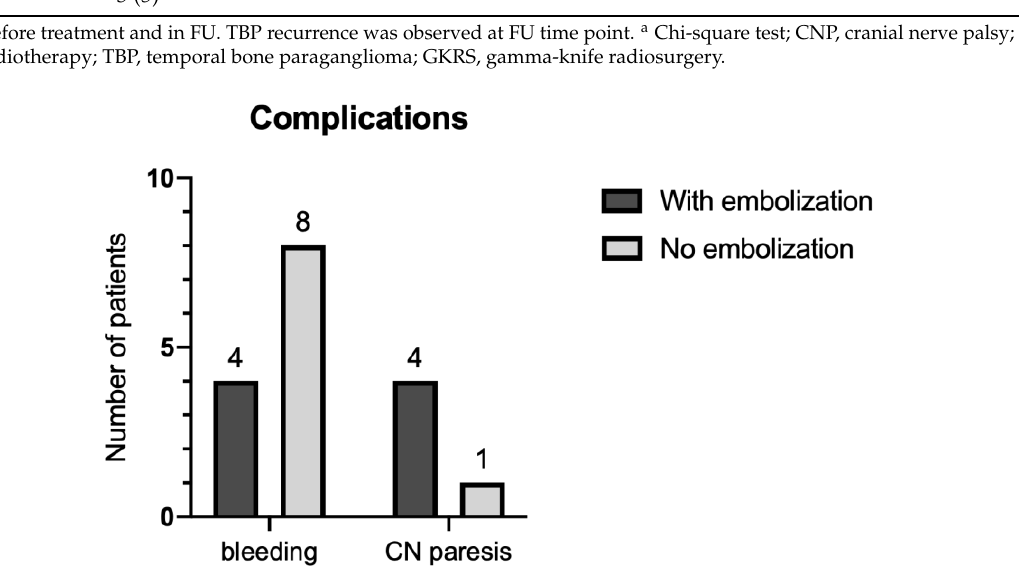
Figure 4. Patients with complications (bleeding and CN paresis) divided into embolized and non- embolized groups. CN cranial nerve.